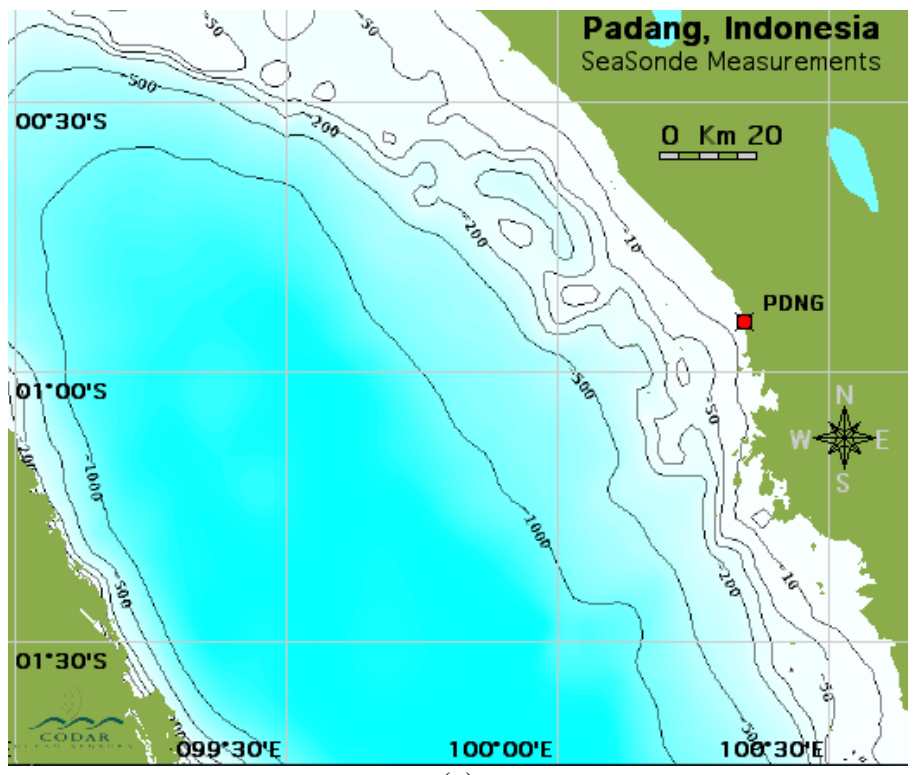
Figure 2. The bathymetry offshore from ( a ) PDNG, ( b ) HUTB,